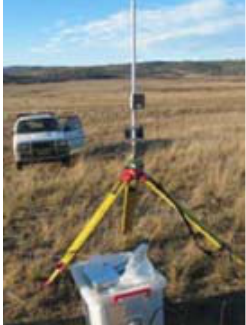
fig. 2. Locata antenna (Barnes et al .